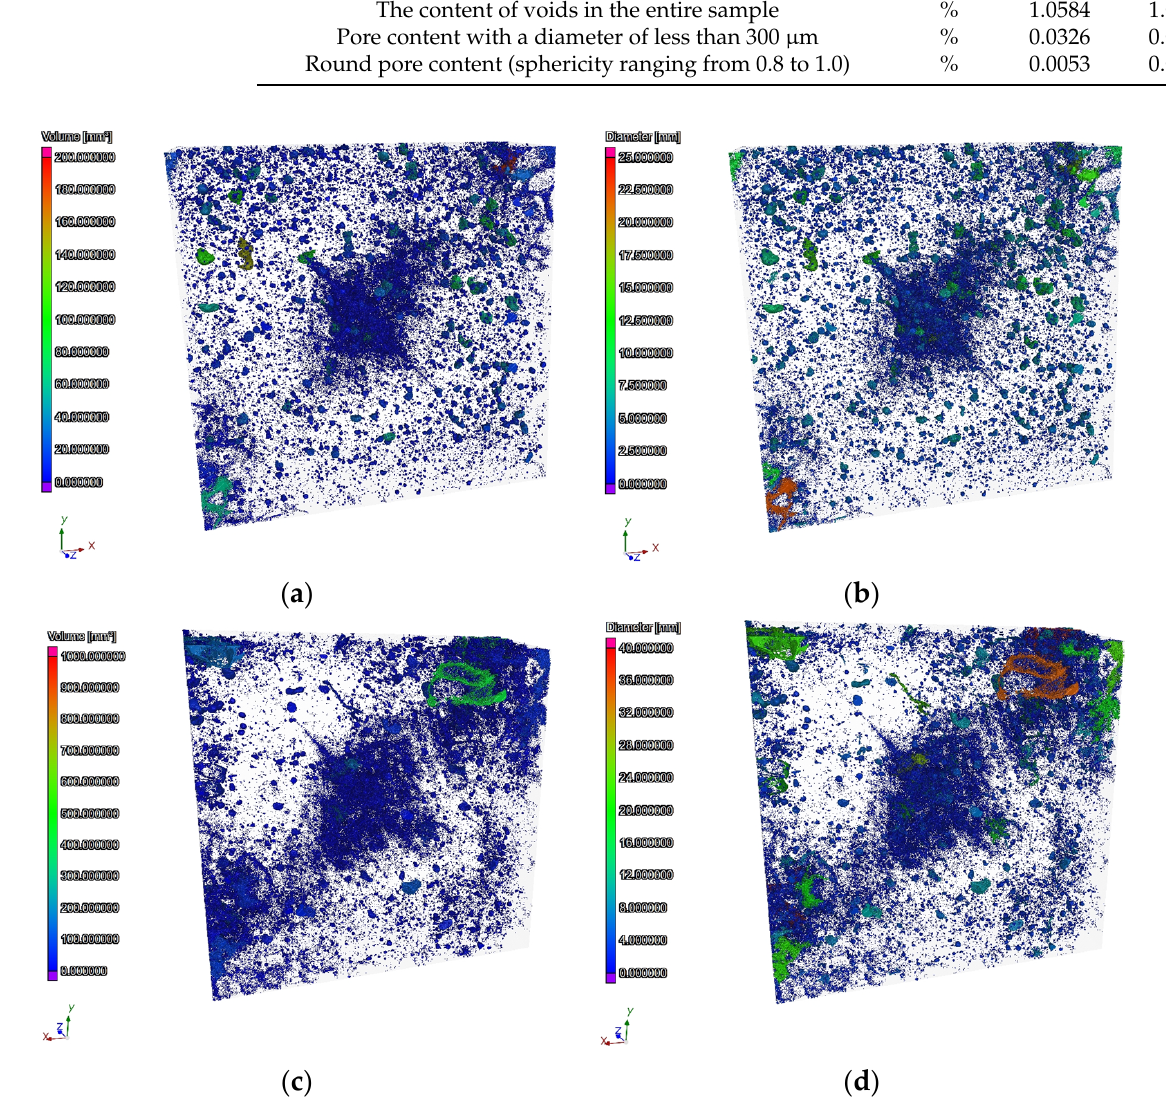
Figure 8. Examples of concrete cross-sections in terms of pore volume (( a ) for C-C series concrete and ( c ) for C-RA series concrete) and in terms of pore diameter (( b ) for C-C series concrete and ( d ) for concrete series C-RA).